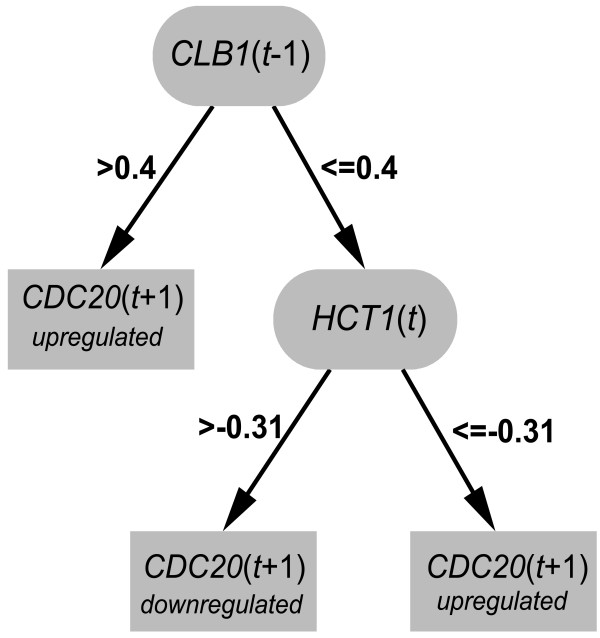
Decision tree for gene CDC20 as an example for extraction of regulatory rules.